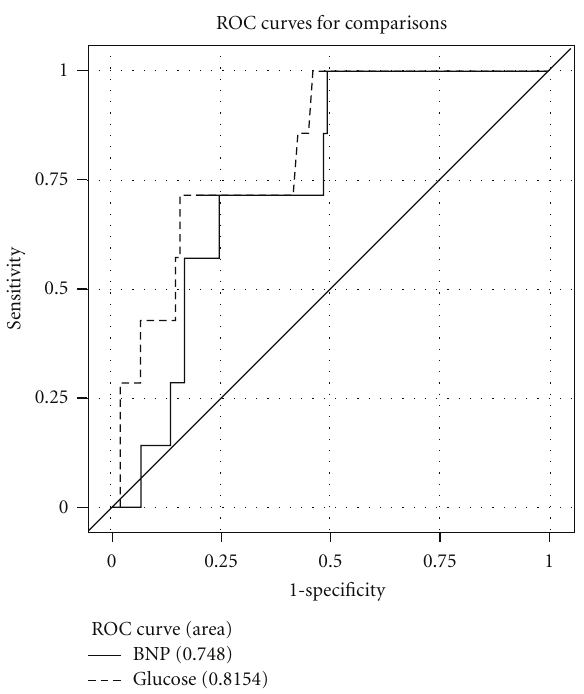
Figure 1: Comparison of glucose versus BNP ROC curve.